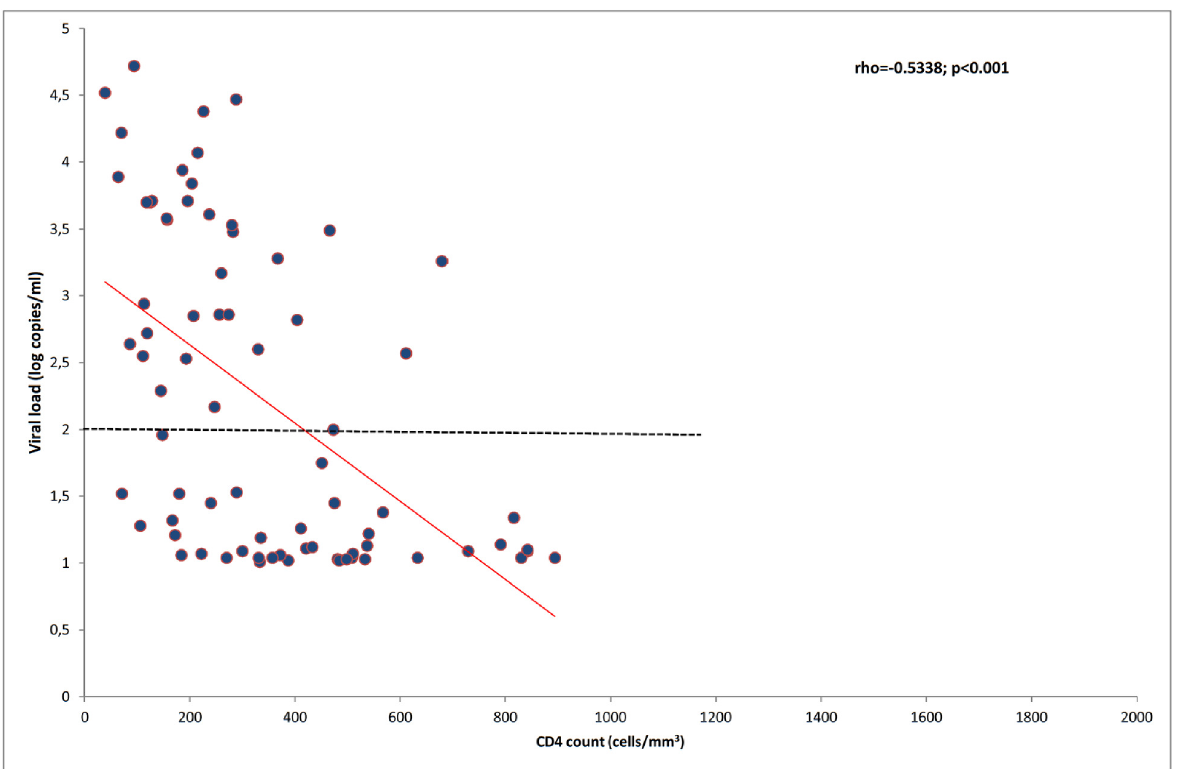
Fig 3. Correlation between plasma HIV-2 RNA and CD4 count among HIV-2 infected individuals on antiretroviral therapy in West Africa.